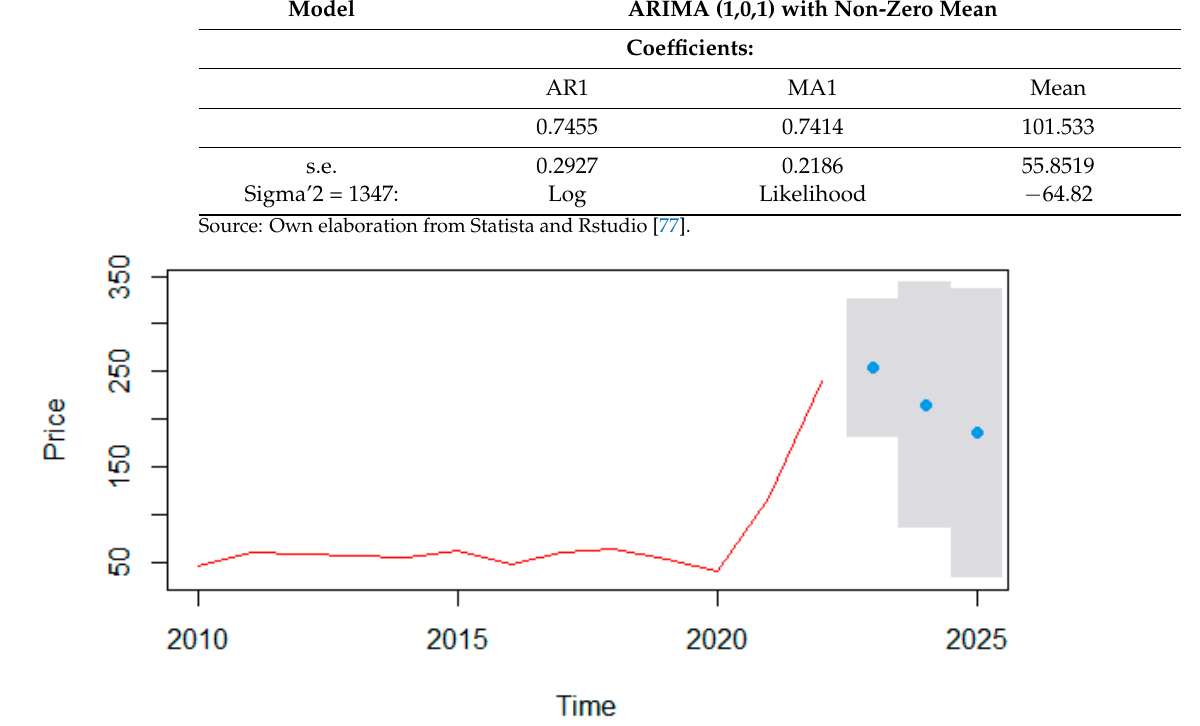
Figure 4. Forecast from ARIMA (1.0.1) between 2023 and 2025 (in euros per megawatt-hour). Source: Own elaboration from Statista and Rstudio [77].